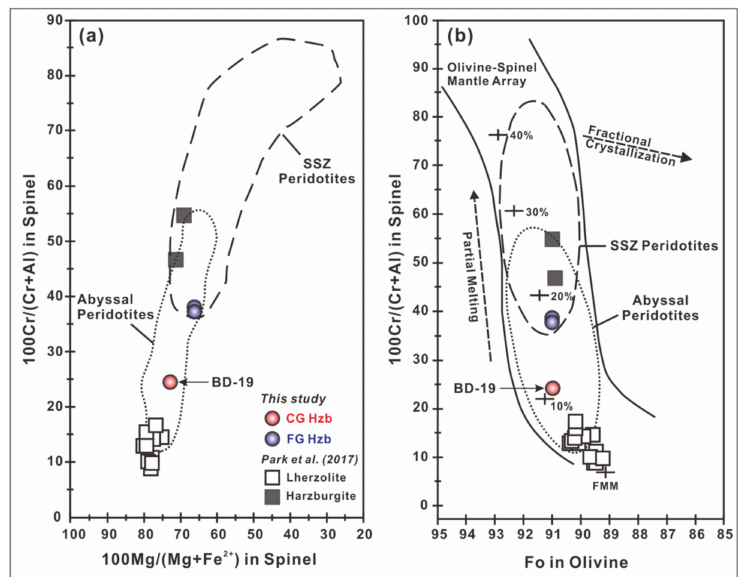
Figure 4. Plots of ( a ) spinel Cr# versus Mg# relationship and ( b ) olivine Fo# versus spinel Cr# relationship. The olivine–spinel mantle array and melting trend (annotated by melting %) given in ( b ) are from Arai [48]. Data sources: abyssal peridotites [49] and suprasubduction zone (SSZ) peridotites [50–52]. FMM = fertile MORB mantle. Previous data from the Baekdusan peridotite xenoliths [21] are also shown as squares for comparison. Coarse-granular (CG; red circles) and fine-granular (FG; blue circles) harzburgite (Hzb) from the Baekdusan